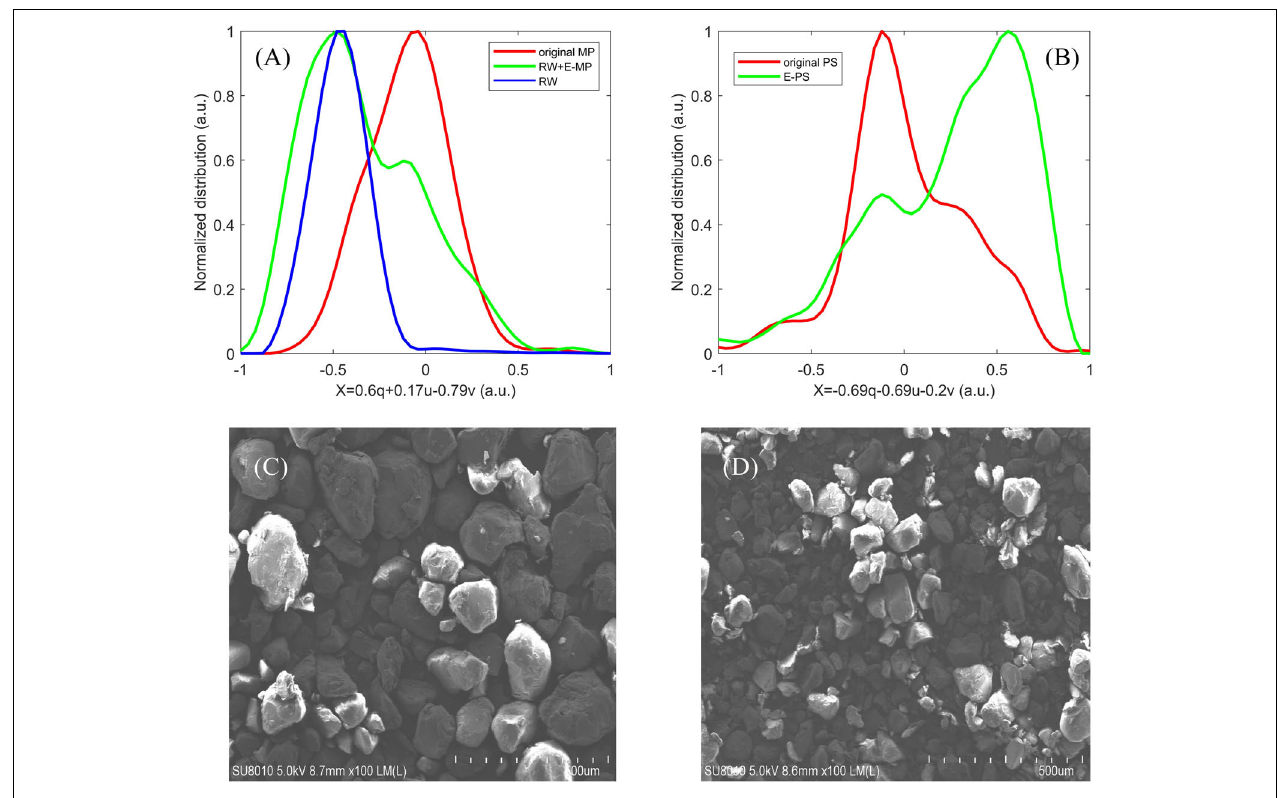
FIGURE 5 | (A) Distribution of Microplastic (MP) in the environment water, the mixed MP, river water (RW), and environmental MP (E-MP). (B) Distribution of PS before and after weathering, original polystyrene (PS), environmental PS (E-PS). (C) 300-mesh PS before weathering. (D) 300-mesh PS after